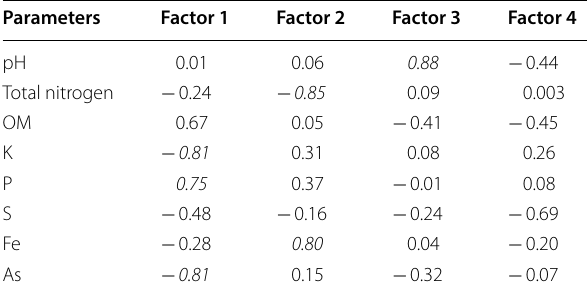
Table 8 Factor loadings obtained with unroasted factor matrix (sub-surface samples)